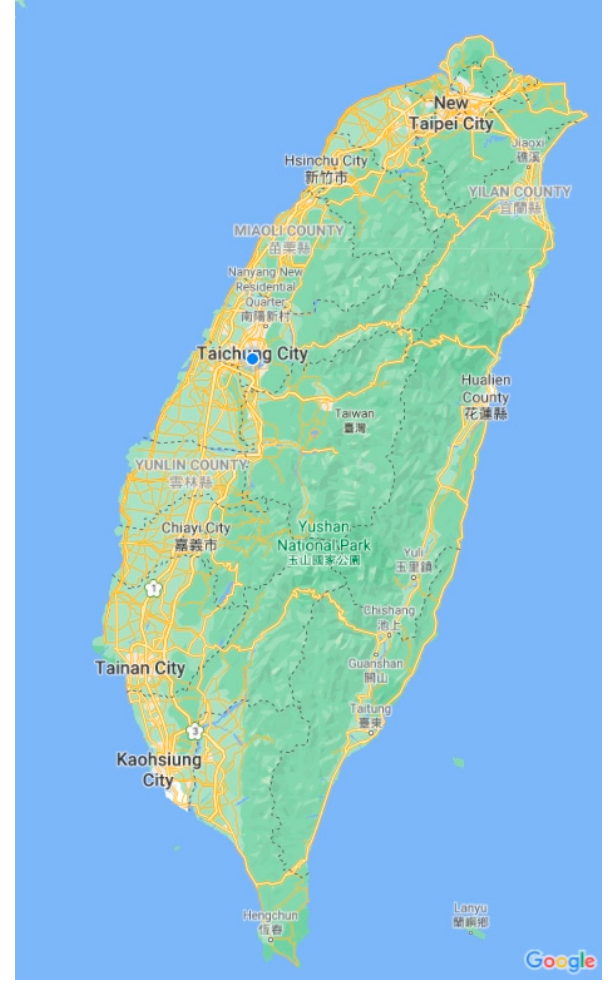
Figure 1. Study Site. Source